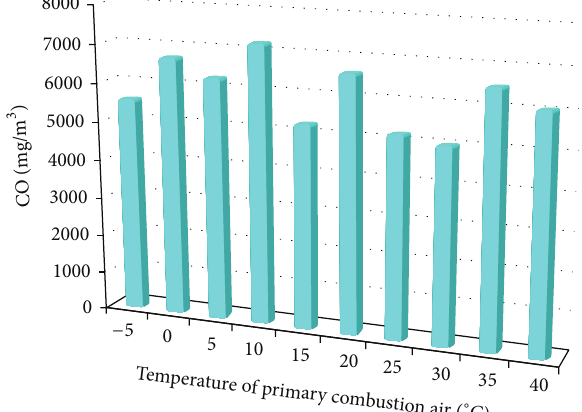
Figure 5: Average CO emissions depending on the temperature change of the primary combustion